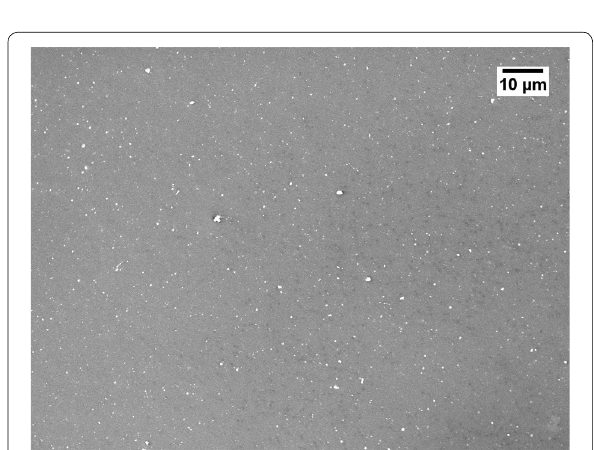
Fig. 4 SEM image of PEI membrane made by GBL and 27 wt% PEI